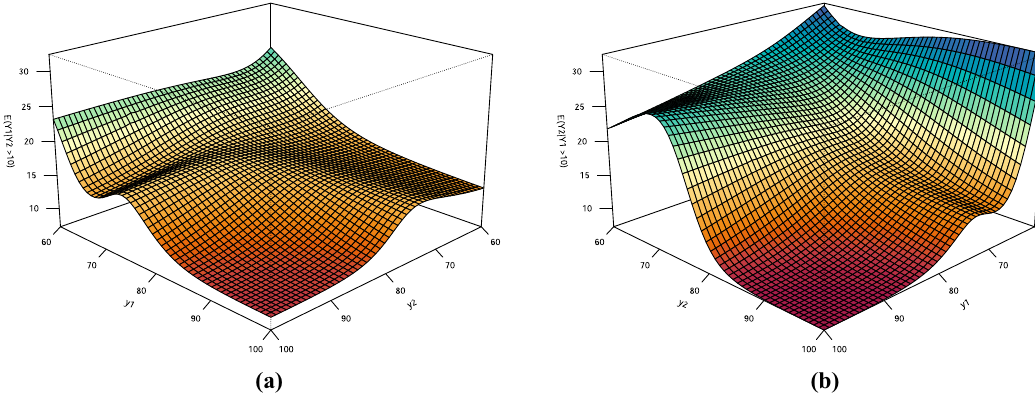
Figure 10: Marginal expected excess survival times, conditional on spouse survival during 10 years. ( a ) Man and ( b ) woman.